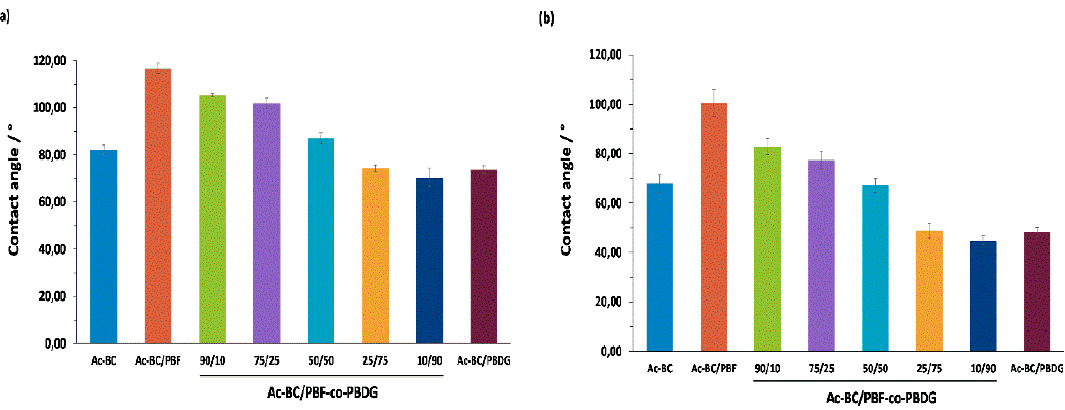
Figure 3. Water contact angles at ( a ) 0 and ( b ) 15 s.